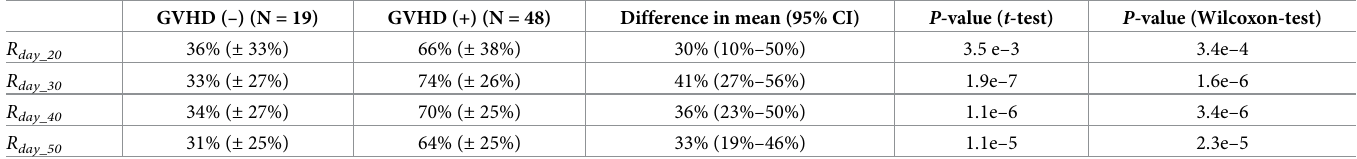
Estimated values and standard deviations of each R day_n (n = 20, 30, 40, and 50) are shown. Estimated differences mean of R day_n (n = 20, 30, 40, and 50) and these 95% confidence intervals are also shown. Results of statistical tests and P -values are also